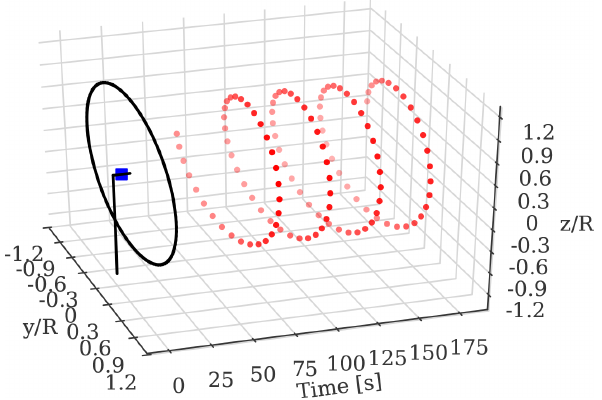
Figure 3. An illustration of the virtual lidar simulator setup run for 175s with simulated time lag. The wind turbine is sketched by the solid black lines; the nacelle-mounted lidar is represented by a square blue marker measuring upstream of the turbine. The trajec- tory of the scanning beam is shown by discrete red